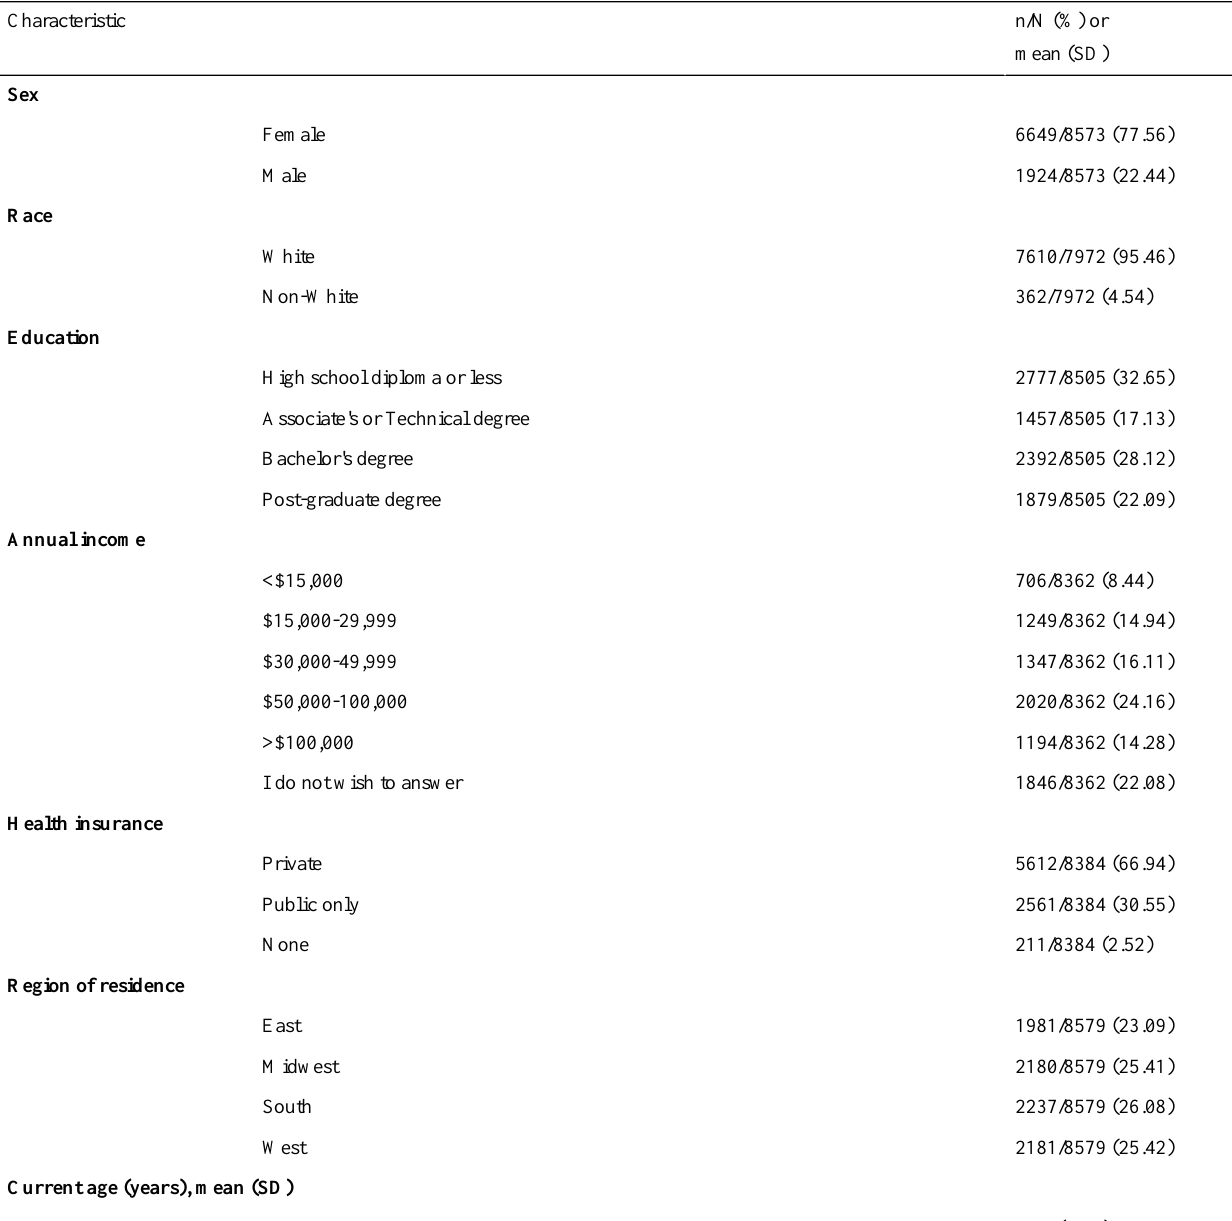
Table 1. Demographic and clinical characteristics of responders to the NARCOMS Fall 2011